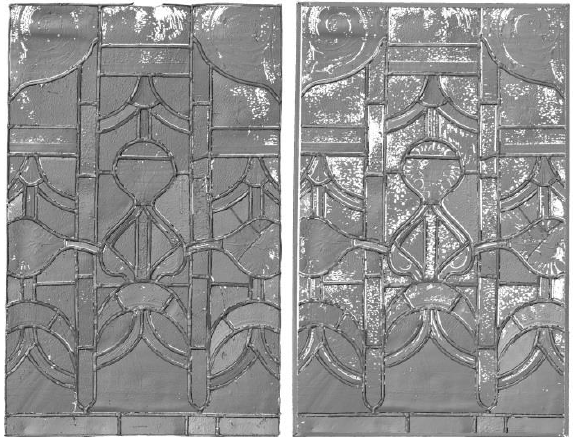
Figure 4. Juxtaposition of window nX4b from Koszewko before (left) and after the conservation